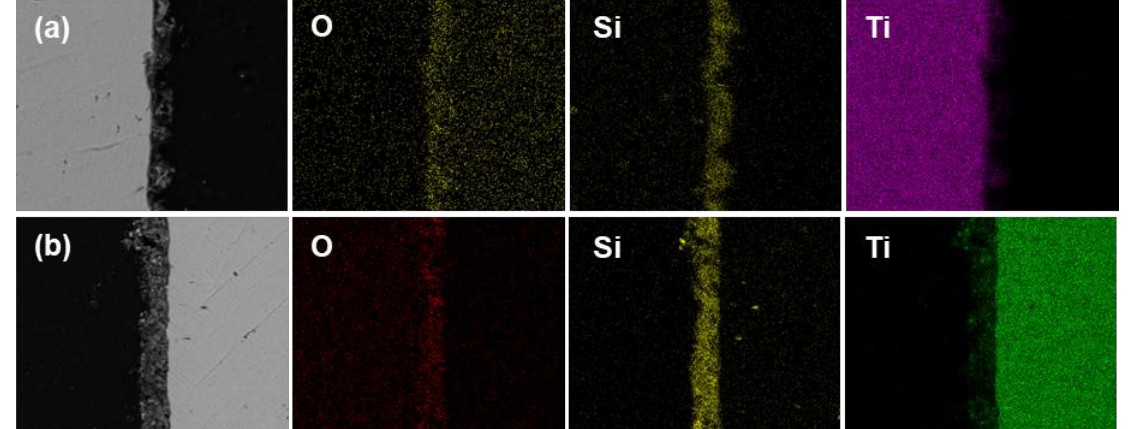
Figure 6. EDS elemental mapping analyses of cross-section of prepared coating by micro-arc oxidation with different time: ( a ) MAO-1 and ( b ) MAO-2 coating.